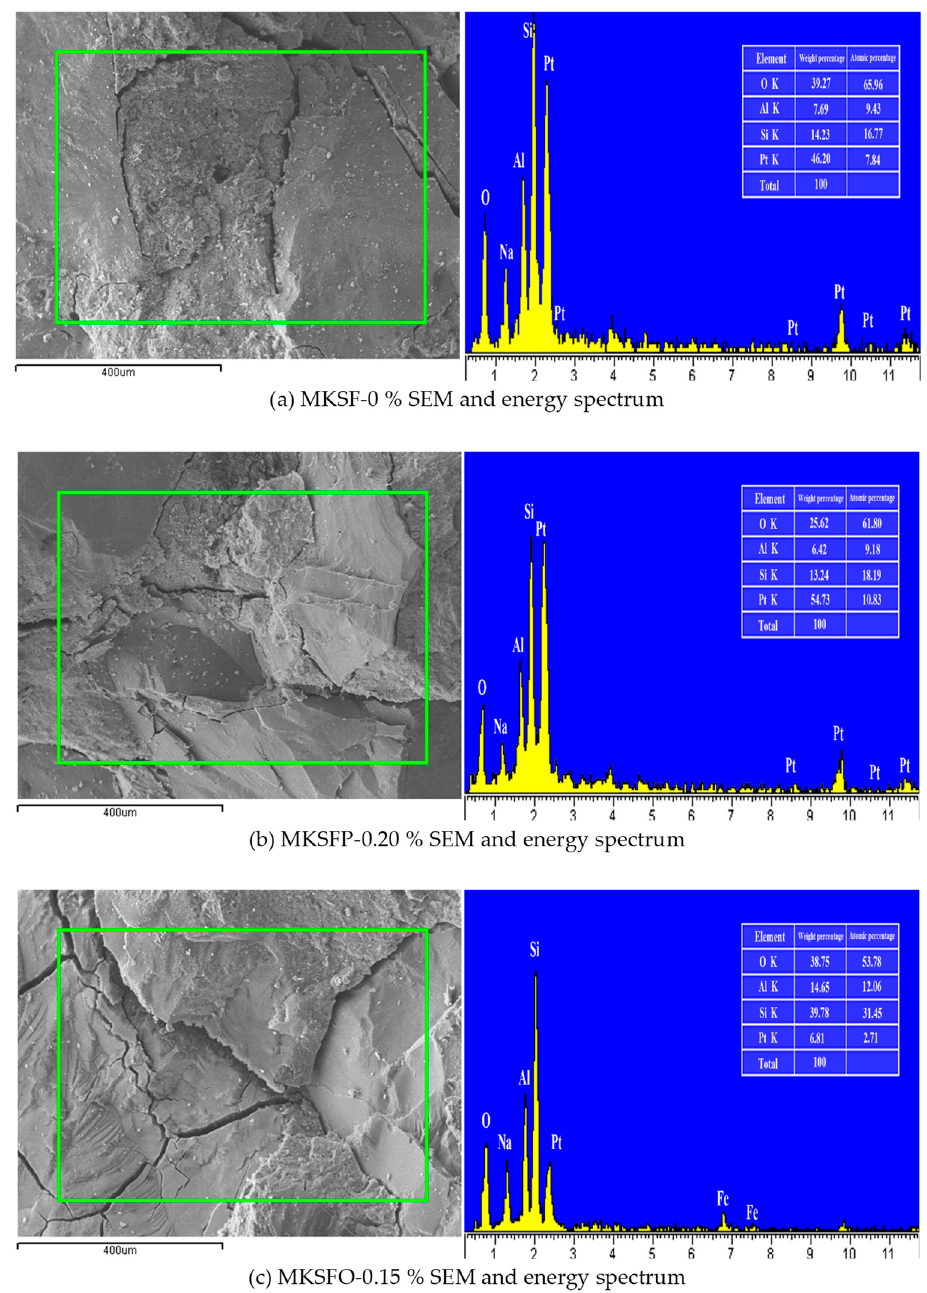
Figure 11. SEM image and EDS energy dispersive spectrum analysis of different defoamer dosage and standard group. Table 10. Si/Al and Na/Al molar ratios of MKSF-0%, MKSFP-0.20%, and MKSFO-0.15%. EDS